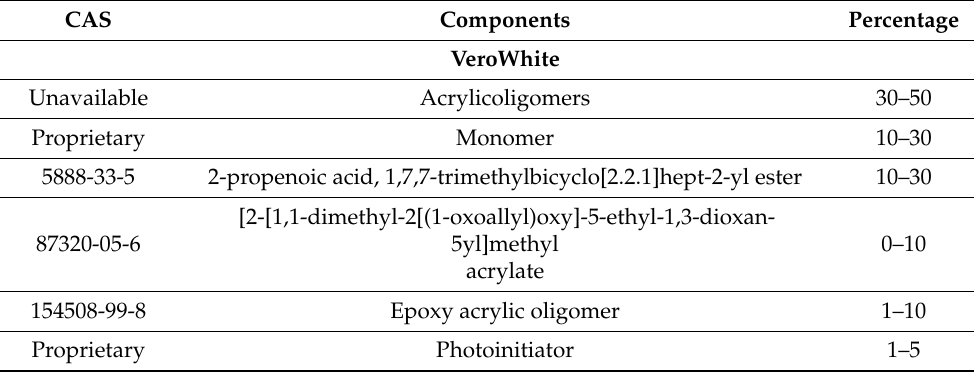
Table 1. Chemical composition of VeroWhite [43].